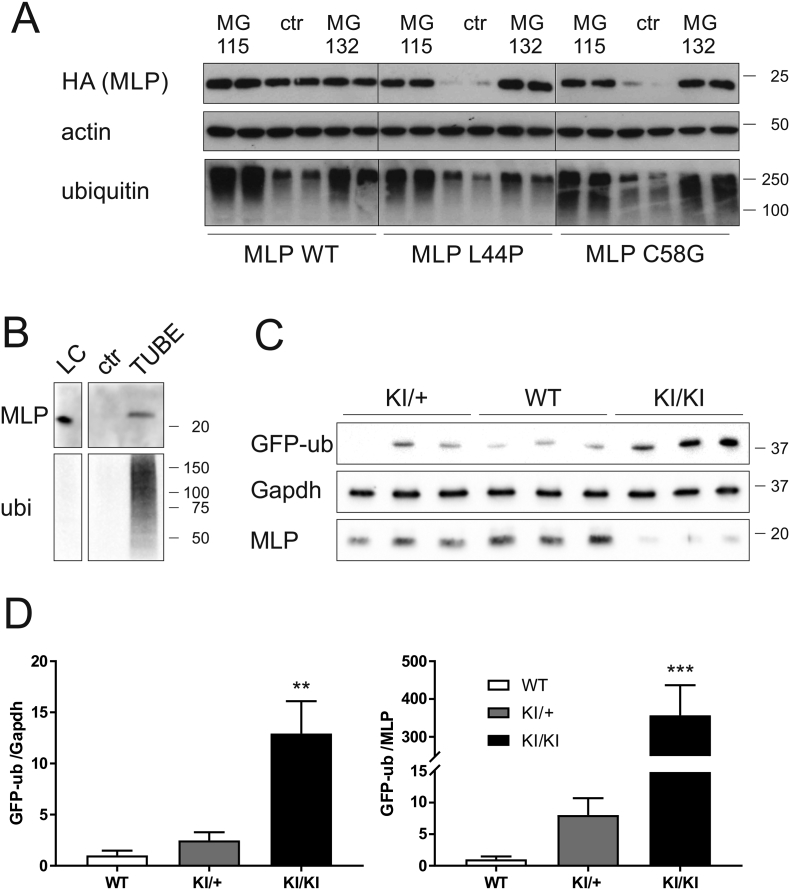
HCM-associated MLP mutant proteins are subjected to depletion by proteasomal pathways: A – NRC were transduced with adenoviral particles as in Fig. 5B and treated with proteasomal inhibitors MG-115 and MG-132. Cell lysates were blotted for HA, detecting the recombinant MLP WT, L44P and C58G. Pan-actin served as loading control and blotting for ubiquitin confirmed efficient inhibition of the proteasome by accumulation of ubiquitinated proteins. In control (ctr, DMSO-treated) cells, MLP L44P and C58G are destabilised, however they are restored to WT protein levels upon proteasomal inhibition. B – TUBE assay: Ubiquitinated proteins were pulled down from Csrp3 KI/KI heart lysate (treated in vivo with proteasomal inhibitor MG-262 1 μmol/kg BW for 20 h) using immobilised tandem ubiquitin-binding entities (TUBE). Agarose matrix without TUBE served as control (ctr). Lysate controls are shown (LC, 1% of input). Blotting for ubiquitin (ubi) indicates the enrichment of ubiquitinated proteins in the TUBE pulldown. Blotting for MLP shows specific pulldown of MLP with TUBE, indicating ubiquitination of the protein. Please note the higher molecular weight (>20 kDa) than normal endogenous MLP (< 20 kDa, see panel C). C – Proteasomal overload in the KI/KI mice: The ubiquitin G76 V GFP reporter (GFP-ub) was crossed onto mice of the three genotypes. Samples of hearts of 6 month old mice were blotted for GFP and increased accumulation of GFP-ub was observed in the KI/KI mice, indicating proteasomal overload. Blotting for MLP illustrates the genotype of the mice and Gapdh served as loading control. The position of marker proteins is indicated (molecular weight in kDa). D – Quantification of GFP-ub induction (blots relating to panel C), expressed relative to Gapdh (left) or MLP (right) protein levels, n = 6 per group. A striking induction of the GFP-ub reporter is observed in KI/KI hearts; **p < 0.01, ***p < 0.001.